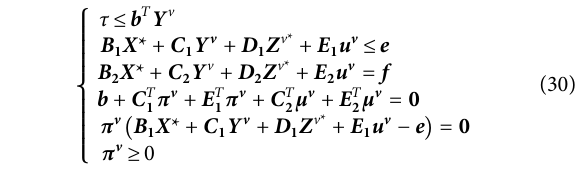
Algorithm 1. The nested C and CG